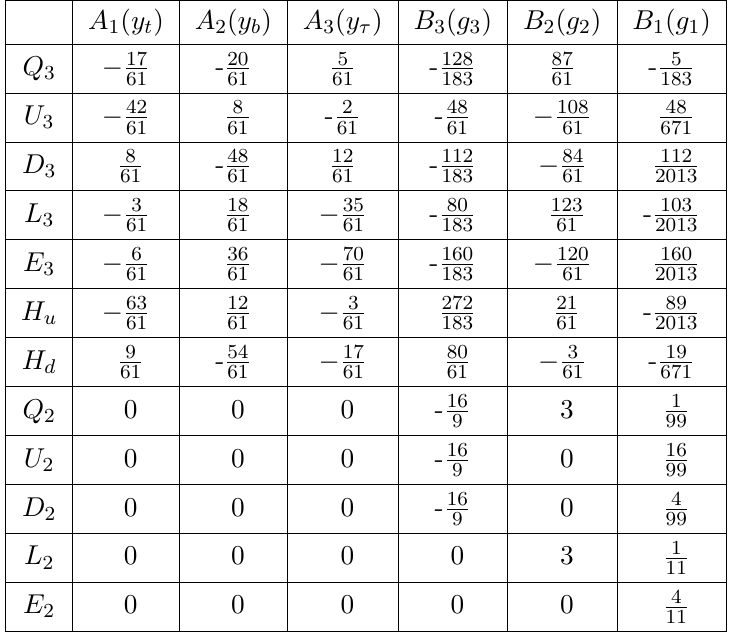
Table 1 . Relevant coe(cid:14)cients in wavefunction expansion with N F = 0